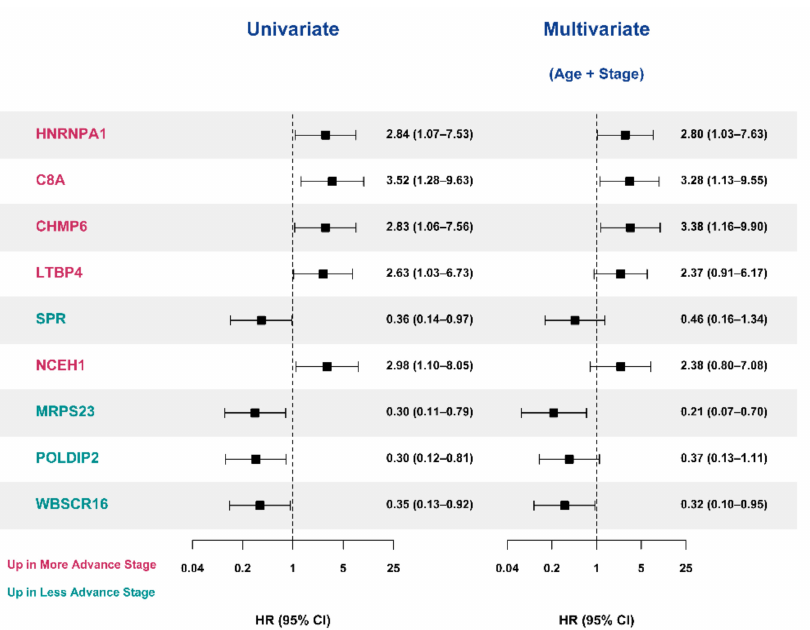
Figure 6. Cox proportional hazard regression models of significant DEPs in SNUH cohort. When Cox proportional hazard regression model analysis was performed on the feature-selected pro- tein, nine proteins with significant differences were identified. ACC—adrenal cortical carcinoma; C8A—complement C8 alpha chain; CHMP6—charged multivesicular body protein 6;